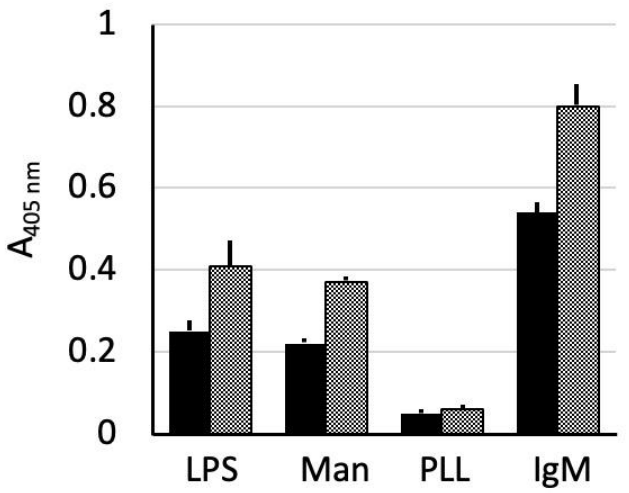
Figure 4. Deposition of C4-1 and C4-2 on model target molecules of the complement system assayed via ELISA with anti-C4-1-NTR (black bars) and anti-C4-2-NTR (gray bars). Abbreviations of the targets: LPS, lipopolysaccharide from E. coli ; Man, mannan from yeast; PLL, poly-L-lysine; IgM, carp immunoglobulin M.